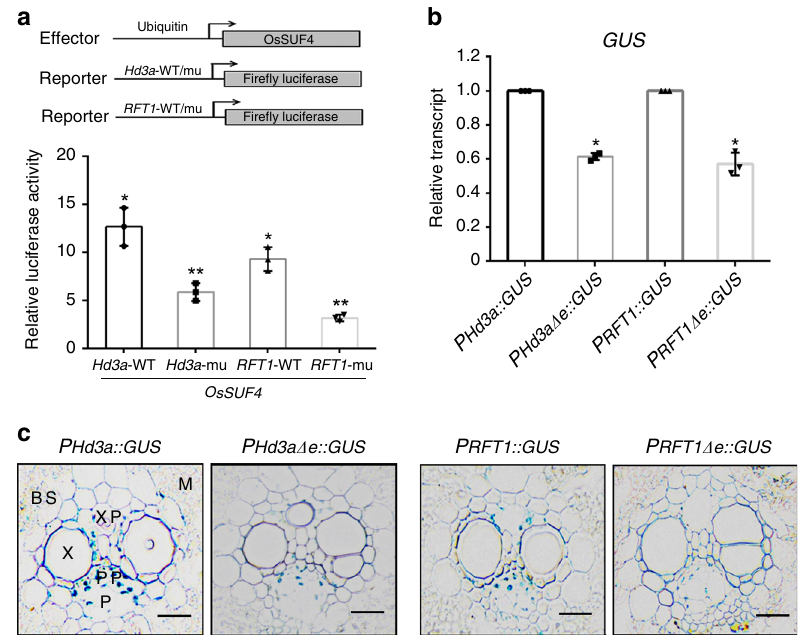
Fig. 6 The 7-bp DNA element is important for OsSUF4 activation in rice. a Dual luciferase assay to test the ability of OsSUF4 to activate wild-type (WT) or mutated Hd3a and RFT1 promoters in planta. Upper panel: schematic representation of effector and reporter plasmids used in the transient transformation assay in rice protoplasts. Relative luciferase activities of each sample refer to the values normalized to their individual controls. The control for each sample was the same individual reporter construct without co-transfection with the effector construct. Values are the mean ± SD of three independent biological replicates. *Signi fi cant differences between WT and negative control (Student ’ s t -test: * P < 0.01). **Signi fi cant differences between WT and mutated reporters (Student ’ s t -test: ** P < 0.01). b Relative transcripts of GUS by RT-PCR analysis in P Hd3a :: GUS , P RFT1 :: GUS , P Hd3a Δ e :: GUS , and P RFT1 Δ e :: GUS plants (Student ’ s t -test: * P < 0.01). c Transverse leaf section using 35-day-old transgenic rice plants of P Hd3a :: GUS , P RFT1 :: GUS , P Hd3a Δ e :: GUS , and P RFT1 Δ e :: GUS